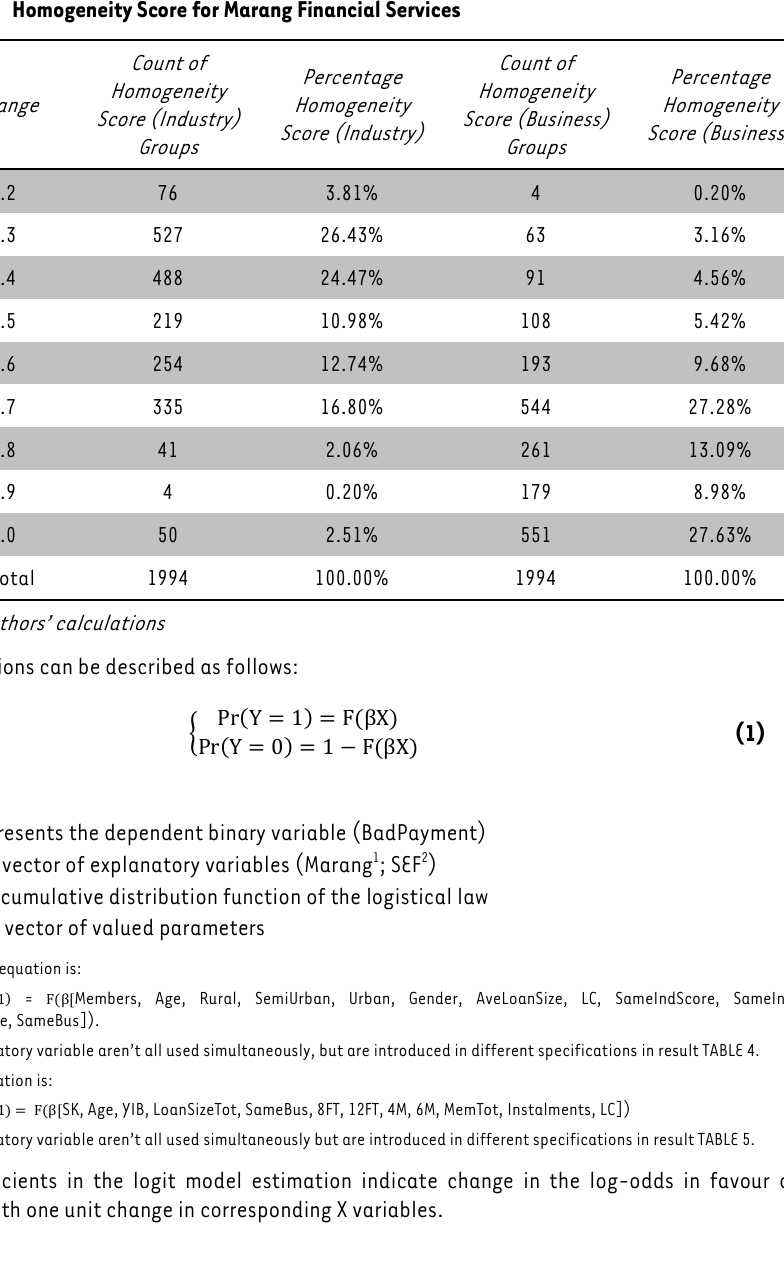
TABLE 4: Homogeneity Score for Marang Financial Services